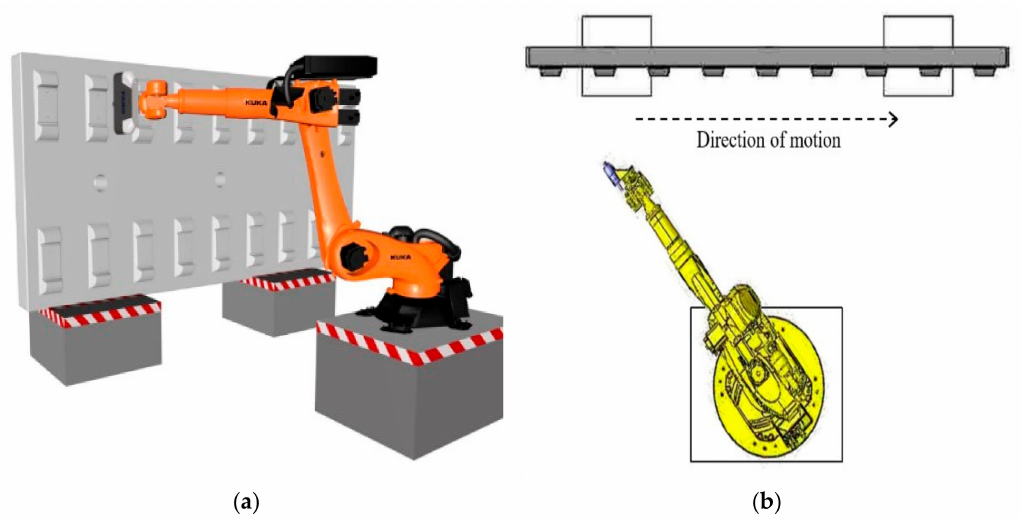
Figure 1. Overall design and operation of the detection system: ( a ) The detection system overall architecture; ( b ) The system moving